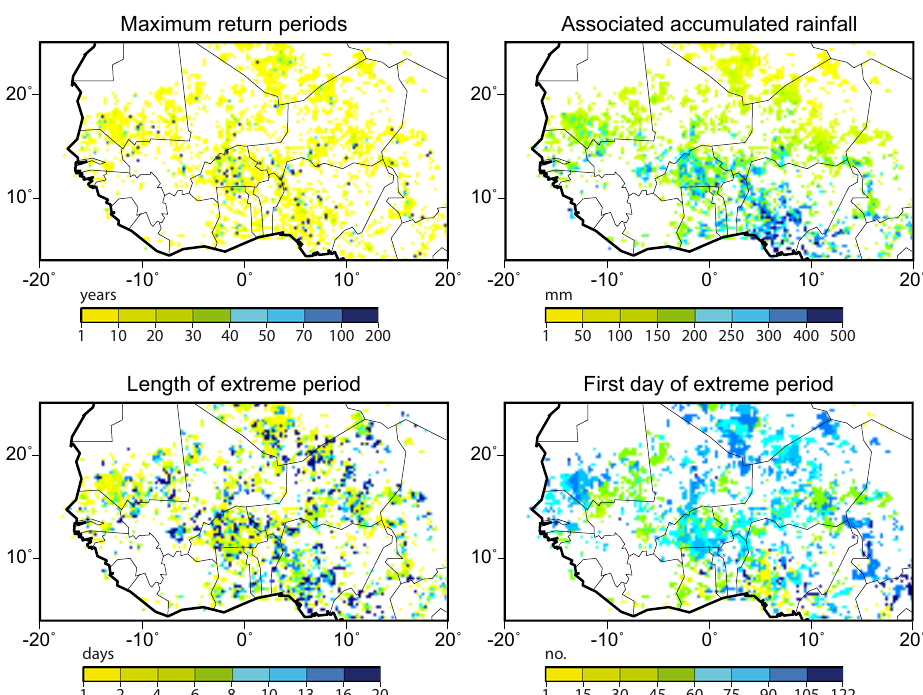
Fig. 3. Characterization of extreme rain events during JJAS 2007 (based on Paeth et al., 2011; see there for further explanations).